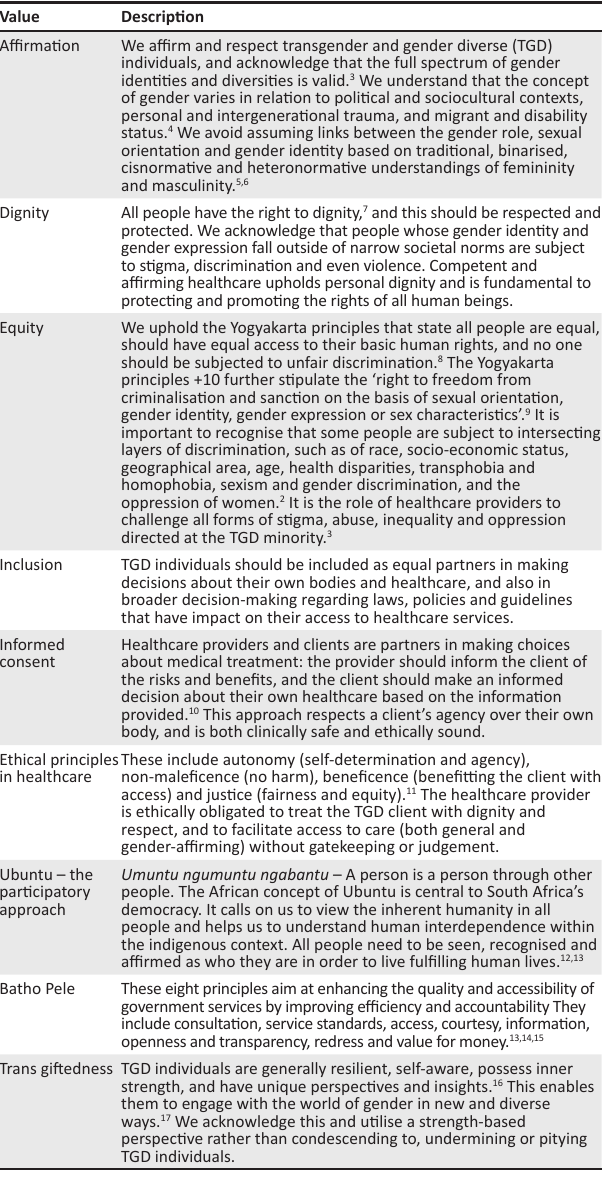
TABLE 1: Values underpinning this